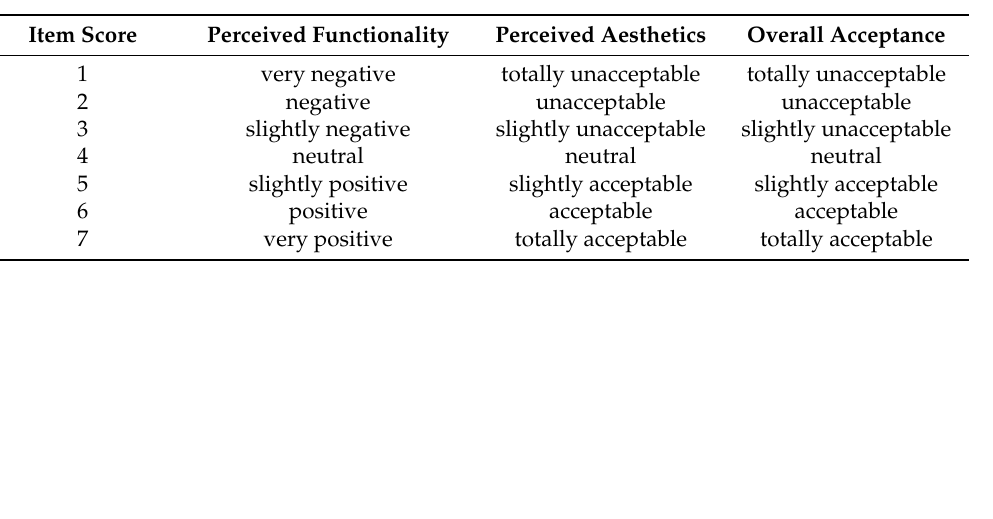
Table 4. Scoring table for the post-test questionnaire for the factors with their semantic meaning and the corresponding value of 1–7 in the Likert scale